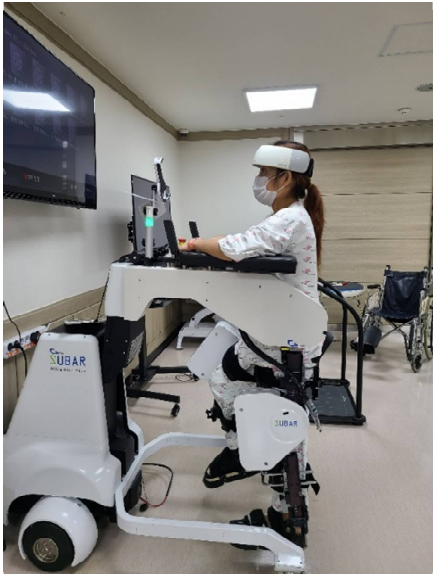
Figure 2. A patient wearing fNIRS during robot-assisted gait training.